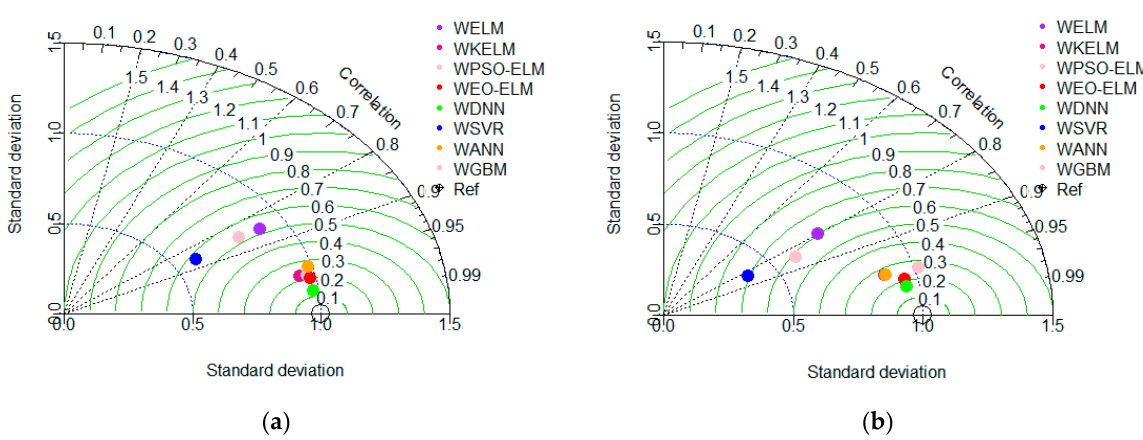
Figure 19. Statistical comparison for all models for catchment Teifi at Glanteifi: ( a ) train, and ( b ) test.